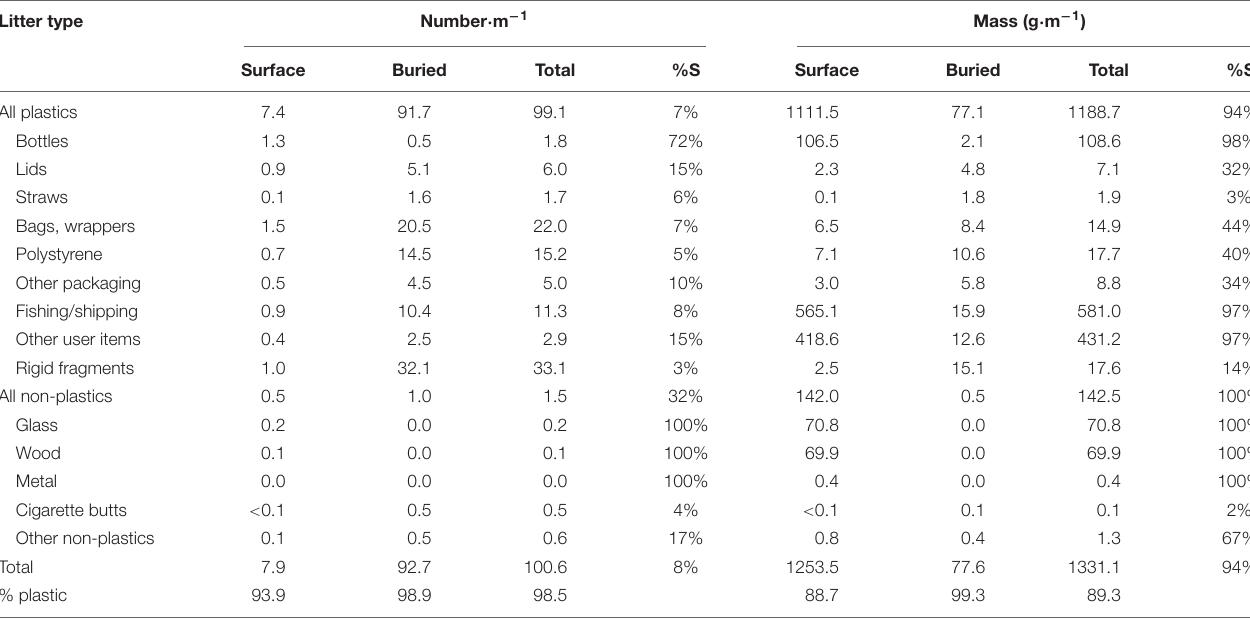
TABLE 2 | The abundance and mass of macro-litter per meter of beach in the West Coast National Park, South Africa, in 2010 sampled by four 50 m-transects for surface litter each with two paired 1-m transects for buried litter, and the percentage of surface litter of the total (%S). Litter